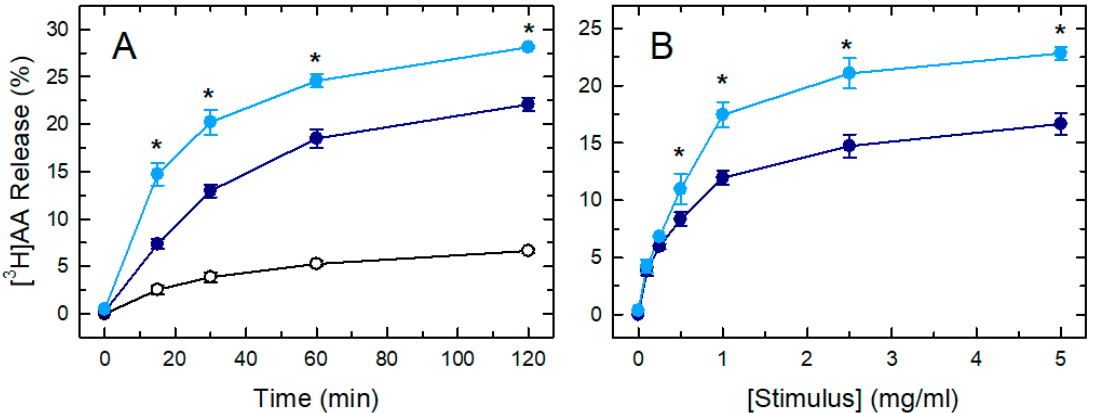
Figure 1. Comparative analysis of the [ 3 H]arachidonic acid ([ 3 H]AA) release response of mouse peritoneal macrophages responding to either zymosan or serum-opsonized zymosan (OpZ). The cells, prelabeled with [ 3 H]AA, were either untreated (open symbols) or treated with zymosan (dark blue) or OpZ (light blue). ( A ) Time-course of [ 3 H]AA release (both stimuli added at 1 mg / mL). ( B ) Concentration response curves (1 h incubation). Afterward, the extracellular media were removed and analyzed for 3 H-radioactivity content. The data are expressed as mean values ± S.E.M. ( n = 6). * p < 0.05, significance of OpZ-stimulated cells versus zymosan-stimulated cells. Next, we used LC/MS to determine the eicosanoids released into the extracellular media of macrophages when challenged with either zymosan or OpZ. The results are shown in Figure 2. Consistent with the AA release data, although zymosan stimulation generally produced lower absolute levels of eicosanoids than OpZ, the relative eicosanoid profile was very similar in both cases. PGE 2 constituted by far the major metabolite produced under both stimulation conditions.